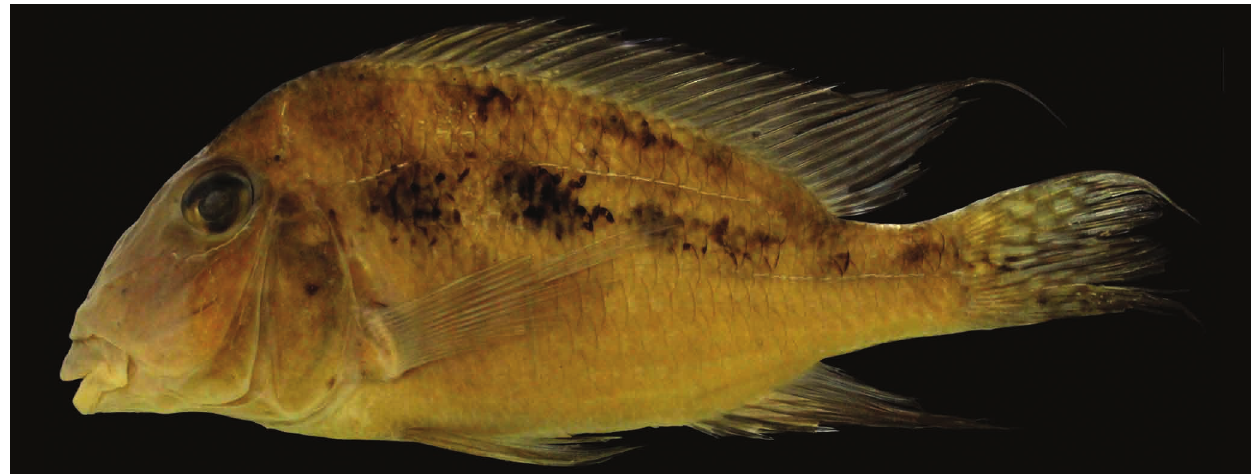
Fig. 1. Geophagus mirabilis , holotype, MCP 48123, 124.1 mm SL, Brazil, State of Mato Grosso, município de Aripuanã, rio Aripuanã upstream from Dardanelos falls. Photograph by Luiz F. C. Tencatt. Description. Morphometric data presented in Table 1.